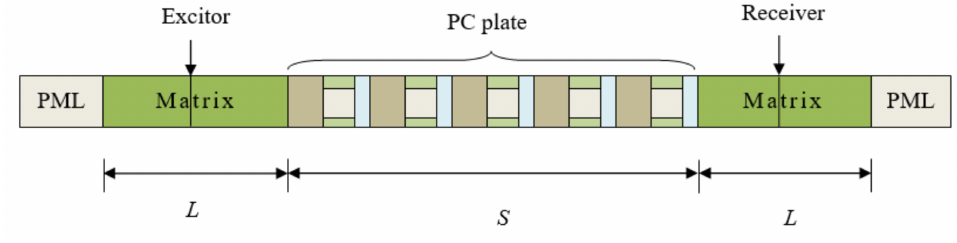
Figure 15. The transmission finite element method (FEM)